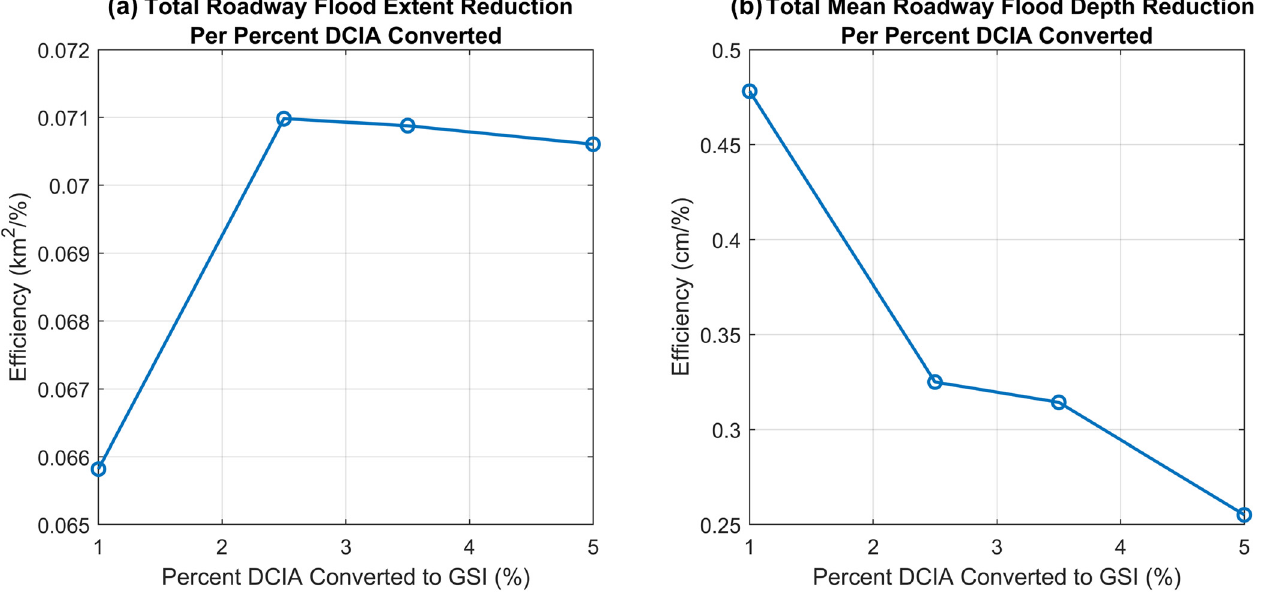
Figure 7. ( a ) Total roadway flood extent reduction over the duration of the simulation (km 2 ) normalized by the percentage of DCIA converted to GSI vs. percent DCIA converted to GSI; ( b ) Total mean roadway flood depth reduction over the duration of the simulation (cm) normalized by percentage of DCIA converted to GSI vs. percent DCIA converted to GSI.